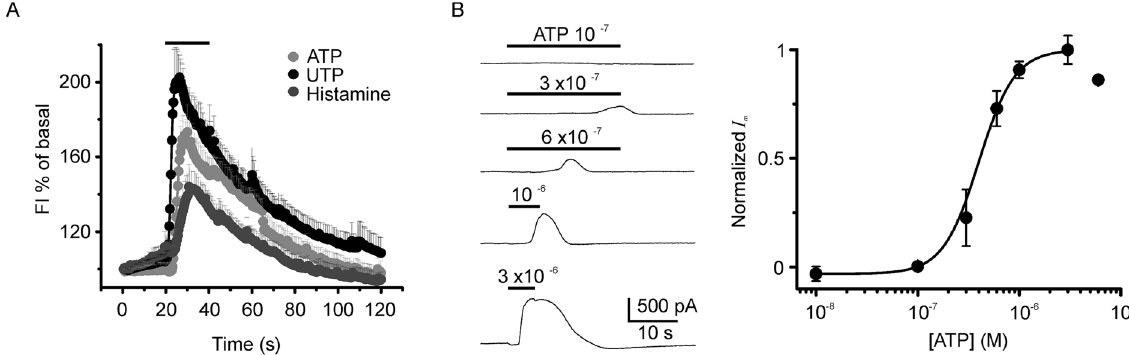
Figure 2. Intracellular Ca 2 + concentration increase in SKOV-3 cells and dose-response of the current generated by ATP. ( A ) Agonists that generated an electrical response also elicited a [Ca 2 + ] i increase that was monitored fluorometrically in cells loaded with Fluo4-AM. All three agonists (10 µ M) elicited a fast response in most cells studied; the graph shows the increase in fluorescence intensity as a percentage of the basal level in 88 cells from different cell cultures. ( B ) Traces correspond to current responses elicited in the same cell that was stimulated with increasing ATP concentrations (washing intervals of 5 min between each application). Similar experiments were repeated in 20 cells, and the peak outward current for each ATP concentration was normalized against the maximal response (at 3 µ M ATP), averaged and plotted. Curve is the fit to the equation: I/Imax = [(A1 − A2)/1 + ([ATP]/EC 50 ) nH ] + A2; by the method of non-linear least squares fitting, where EC 50 = 399 ± 11.4 nM is the half-maximal effective concentration of ATP, nH = 2.45 ± 0.06 is the Hill coefficient, and A1 and A2 are the initial and final normalized I-values,